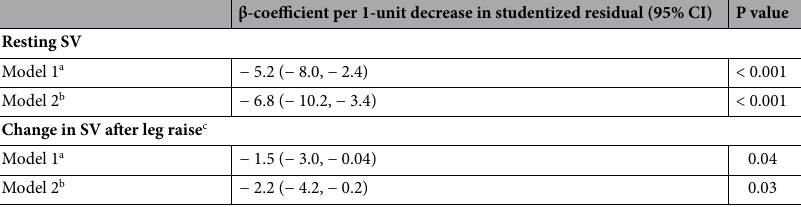
Table 3. Association of disproportionate left atrial myopathy with stroke volume and stroke volume reserve (after passive leg raise maneuver). BMI body mass index, GLS global longitudinal strain, LA left atrial, LAV left atrial volume, LV left ventricular, NT-proBNP N-terminal pro-B-type natriuretic peptide, SV stroke volume. a Adjusted for enrollment site, age, sex, race, BMI, hypertension, diabetes, creatinine, and average E/e ′ .